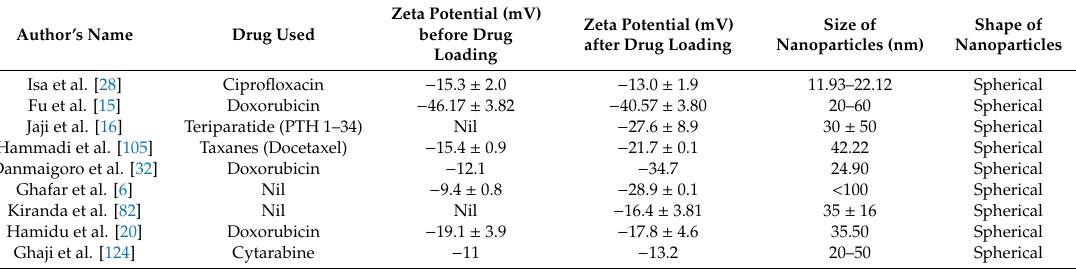
Table 1. Variations in the negative potential charge exhibited by cockle shell-derived calcium carbonate nanoparticles (CSCaCO 3 NPs) before and after loading with di ff erent